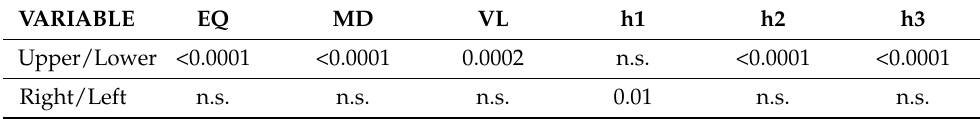
Table 2. Student t -test statistical